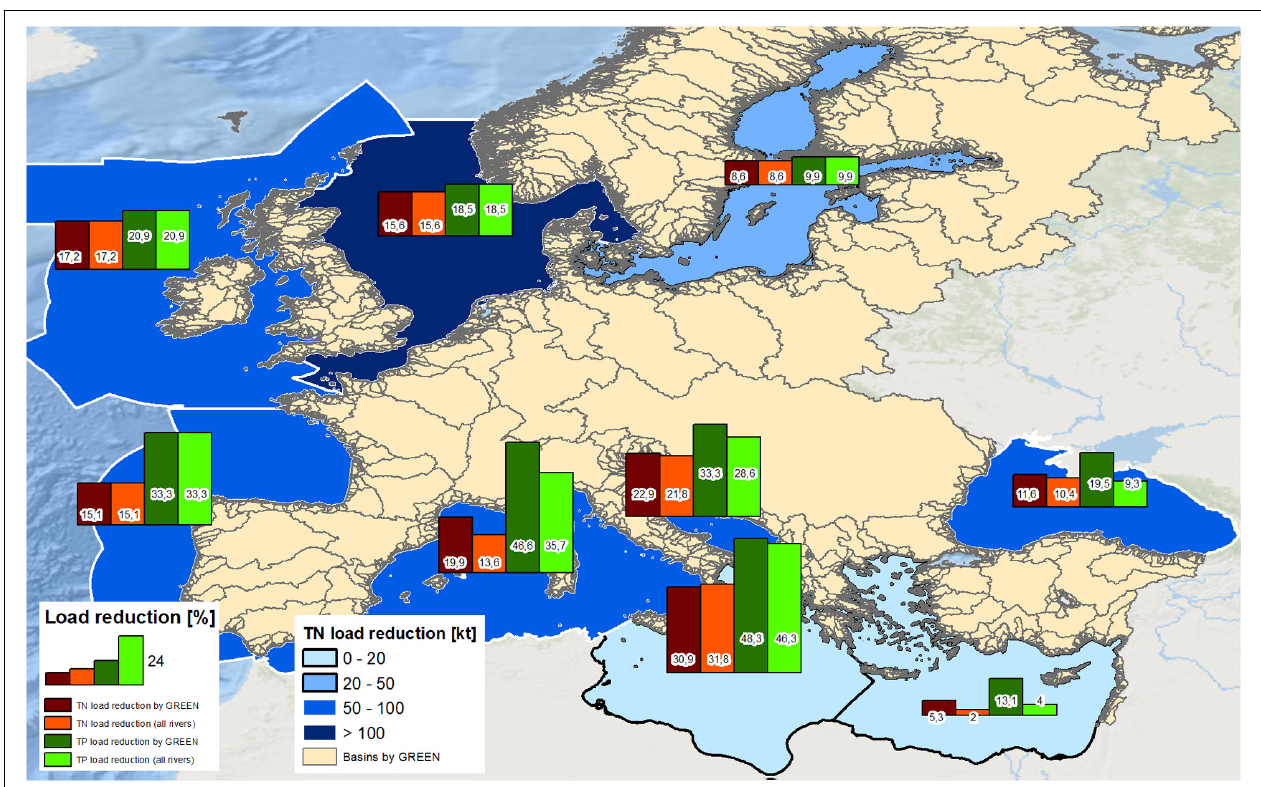
FIGURE 1 | Total reduction of annual TN loads [kt] into the single MSFD regions (blueish colors), bars denote the reduction as percentage of TN (red) and TP loads (green) into the MSFD regions computed purely for the rivers provided by the catchment model GREEN (yellow areas; see Grizzetti et al. (2021) for details) and for all rivers flowing into the single MSFD areas (including the rivers not covered by